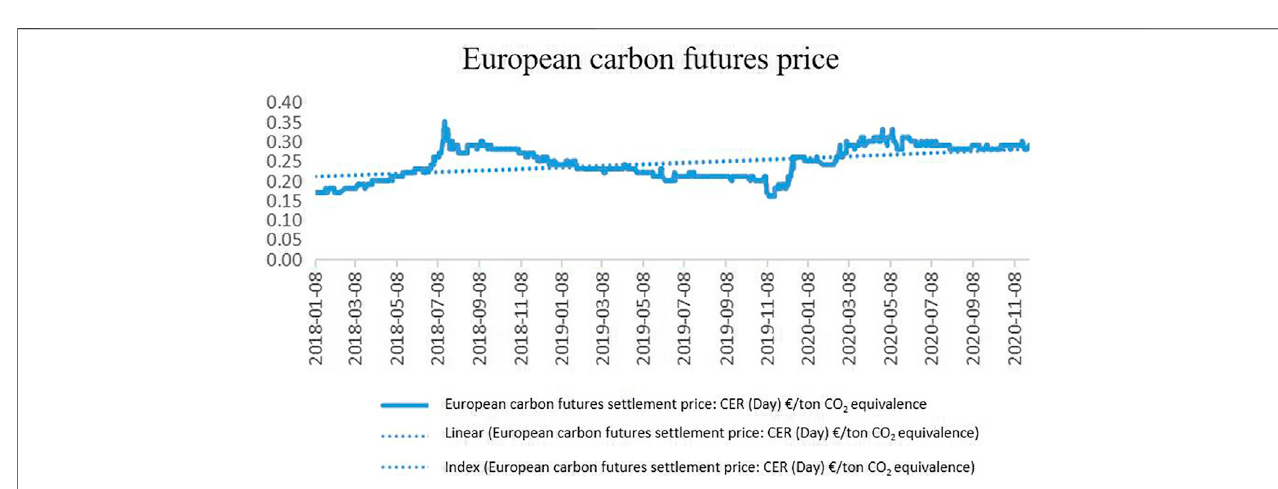
FIGURE 2 | | European carbon emissions futures price (2018 –